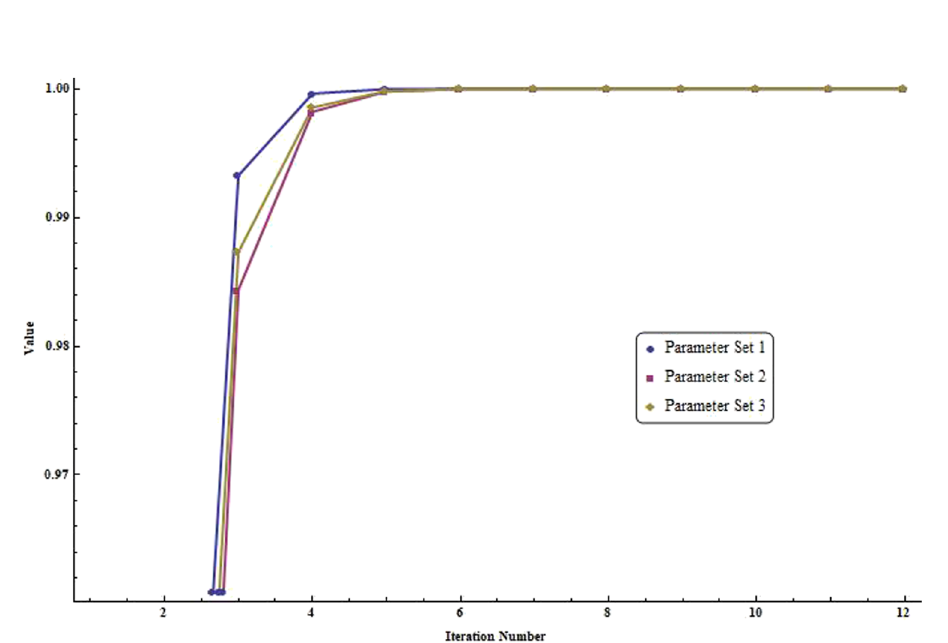
Figure 1: Graph corresponding to Table 1.